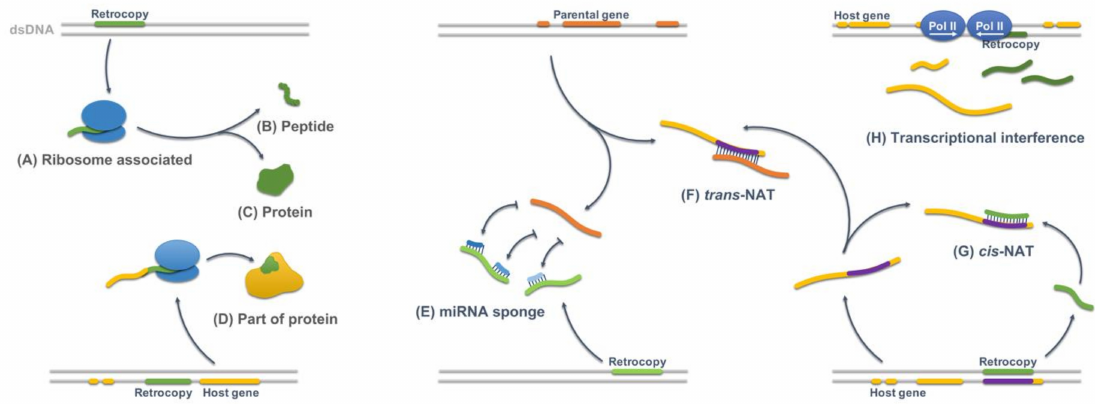
Figure 1. Di ff erent manners of retroposed genes contribution to proteomes and transcriptomes. Retrocopies may associate with ribosomes ( A ) and encode short peptides ( B ) or proteins ( C ). It has been also demonstrated that retrocopies contribute novel exons to existing genes ( D ). They may also regulate their parental and other genes expression as miRNA sponges ( E ), trans -NATs ( F ), and cis -NATs ( G ). Nested retrocopies might also regulate splicing of their hosts via transcriptional interference ( H